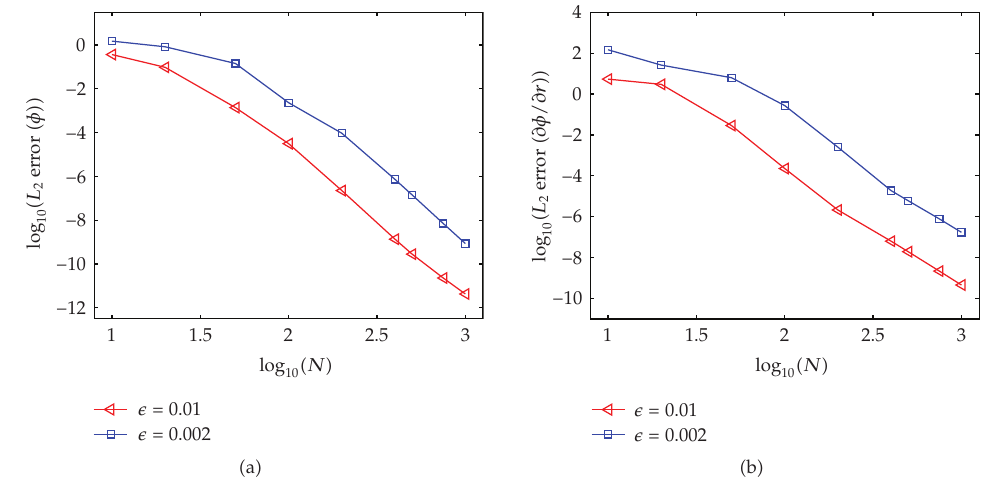
Figure 5: Comparisons of convergence rates of the sixth-order compact schemes for the problem 2 at di ff erent values of (cid:5) : solution error φ (cid:6) a (cid:7) ; derivative error ∂φ/∂r (cid:6) b (cid:7) .